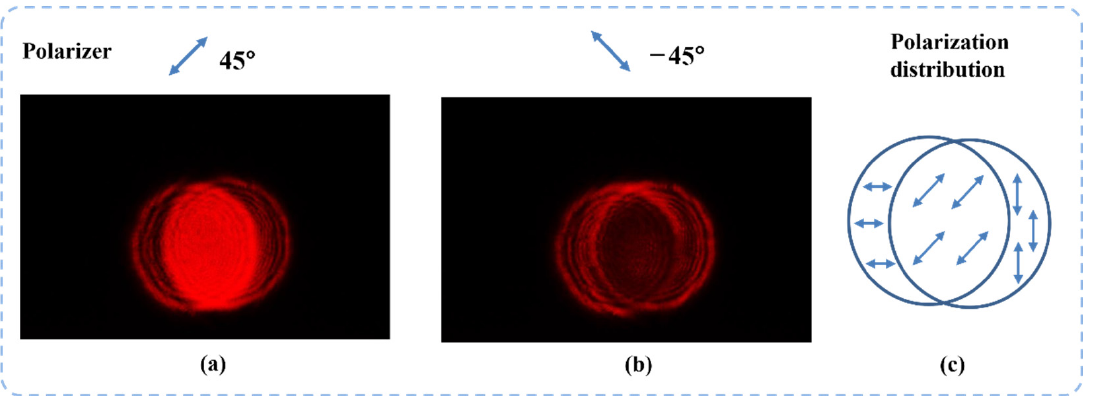
Figure 14. The two orthogonal vector beams are completely aligned. The superposition area of two beams has a single polarization state. ( a ) is the result when the polarizer is placed at 45°, ( b ) is the result when the polarizer is placed at –45°, and ( c ) is the polarization state of the combined beams.